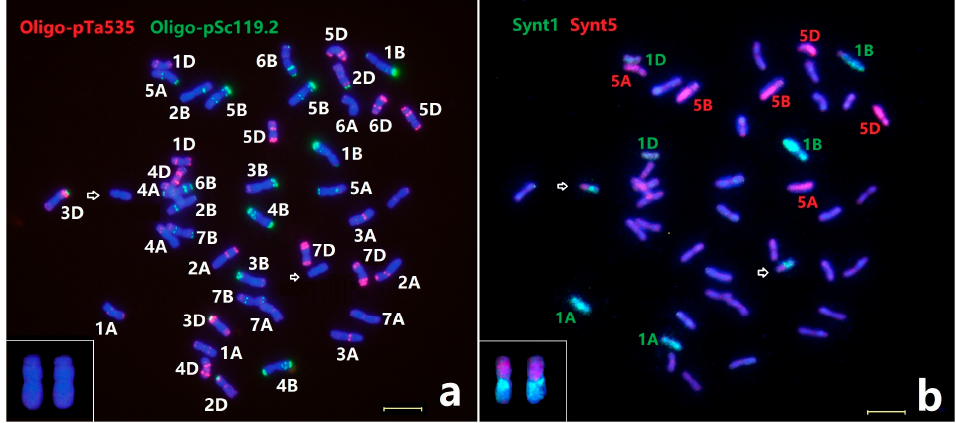
Figure 5. Sequential ND-FISH and Oligo-FISH painting of the wheat– Th. intermedium addition line Z3. ( a ) Probes Oligo-pSc119.2 (green) + Oligo-pTa535 (red) and ( b ) Synt1 (green) + Synt5 (red) are shown. The added Thinopyrum chromosomes are shown by arrows and the cut-and-paste chromosomes at the bottom left. Bars, 10 μ m.